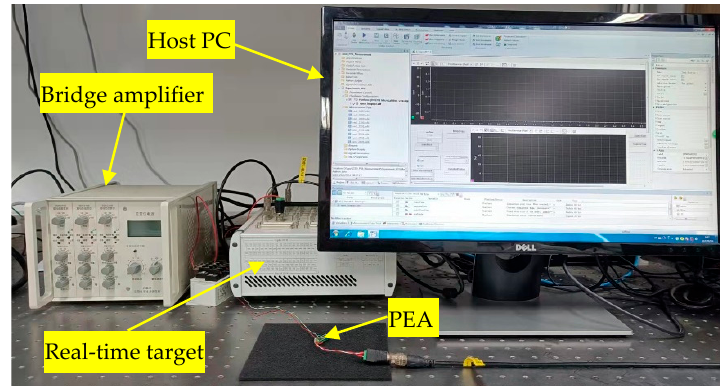
Figure 1. The experimental setup of the system.